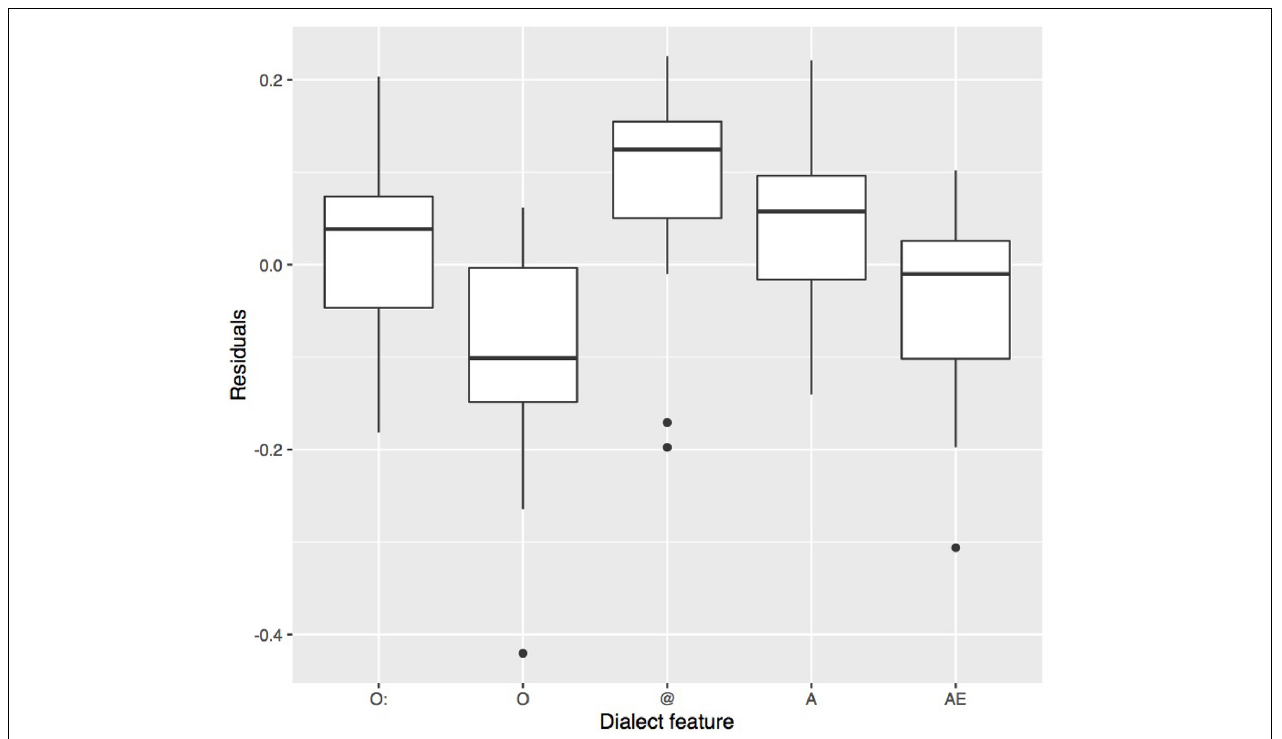
FIGURE 8 | Residuals of the linear model in Figure 7 predicting the proportion of correct answers from the acoustic distance. Values below zero indicate that, based on the acoustic distance, we would expect more correct answers. Values above zero indicate that, based on the acoustic distance, we would expect less correct answers than were actually